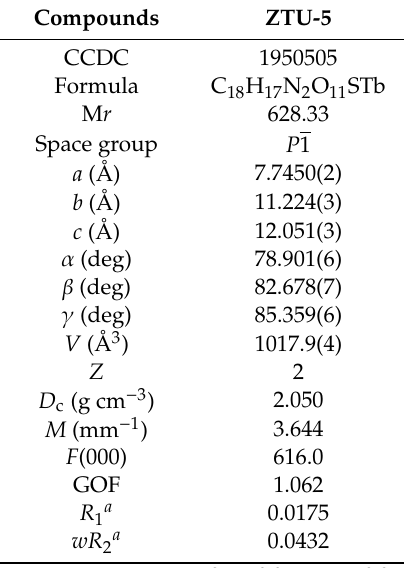
Table 1. Crystal data and structure refinement for [Tb(Habtc)(DMSO)(H 2 O) 2 ] n ( ZTU-5